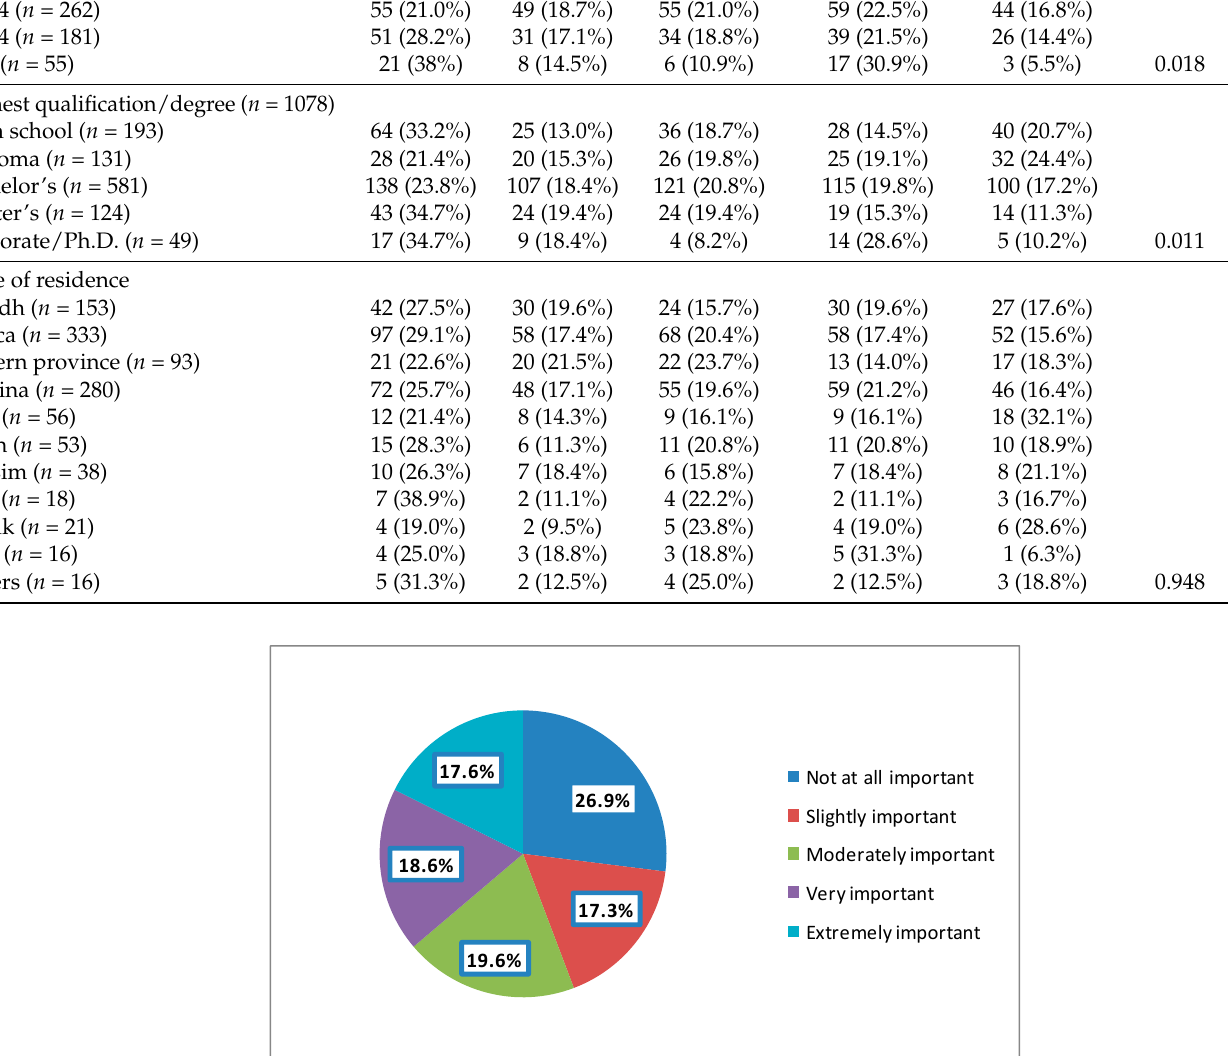
Figure 4. How important an ophthalmologist’s social media site is for